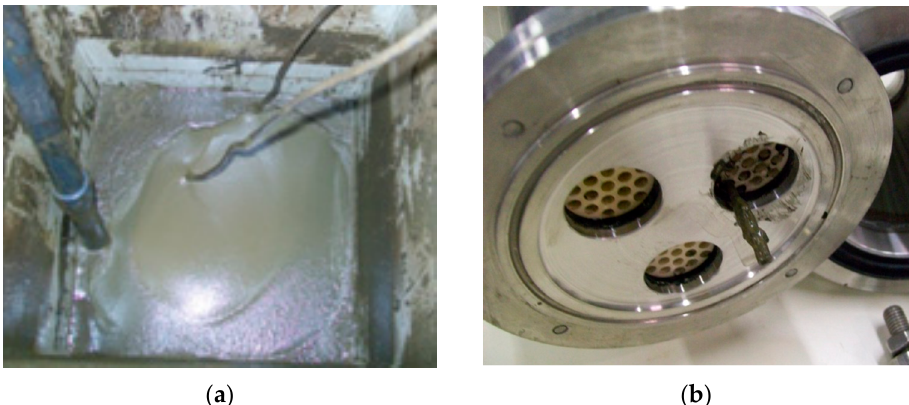
Figure 4. ( a ) OMW3-SG viscous concentrate after VCR = 2.1. ( b ) Removal of OMW3-SG muddy concentrate from the membrane channel with a metallic probe.